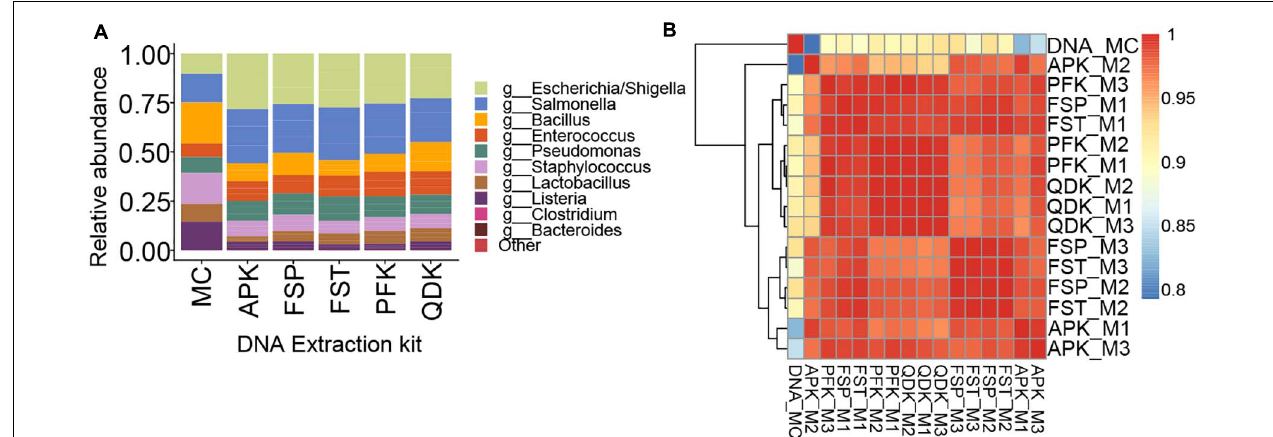
FIGURE 4 | Sequencing results for extractions of a whole cell mock community by five different methods. To control for biases during sequencing, a mock DNA standard was also included in sequencing and analysis of mock community (whole cell) extractions. Within the relative abundance analysis (A) , the top 10 genera are shown for comparison. Species that were not present in more than 10% of the samples were removed. Heatmap showing the Spearman correlation coefficient of pairwise comparison between the samples (B) . The color of the squares indicates the level of correlation. Red squares indicate large correlations; blue squares indicate small correlations. Triplicate extractions with each technique were performed; sample names indicate the extraction technique followed by M1, M2, or M3, indicating each of the triplicate mock community extractions. DNA_MC indicates the mock community DNA standard.